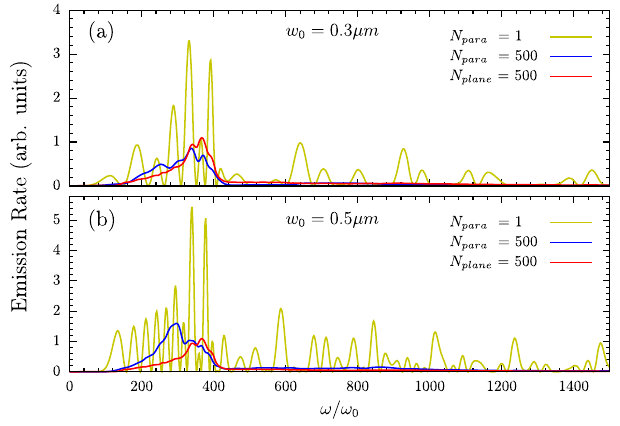
FIG. 7. Thomson emission spectra for an electron bunch in a paraxial beam (500 particles randomly distributed over a disk of radius w 0 in the transverse plane, shown as blue lines and denoted 500 ) are compared with those of a single particle (yellow N para ¼ 1 ). The electron(s) have initial γ 10 lines, denoted N 0 ¼ para ¼ and collide head-on with 0 . 8 μ m, 10 cycle laser beam of peak intensity a 0 ¼ 2 . Panel (a) shows the results for a focusing of θ 0 . 85 ( w 0 . 3 μ m), and panel (b) for θ 0 . 51 0 ¼ 0 ¼ 0 ¼ ( w 0 ¼ 0 . 5 μ m). The spectra is also calculated for the bunch using a plane wave field multiplied by a transverse envelope 500 function exp ð − r 2 =w 2 0 Þ (red lines, denoted N plane ¼